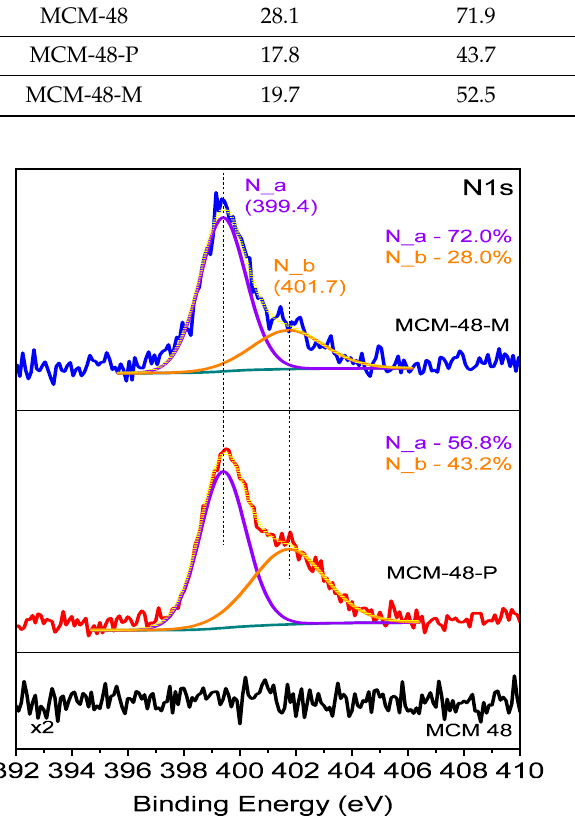
Table 3. XPS data for the MCM-48-P and MSM-48-M samples. Si (at%)